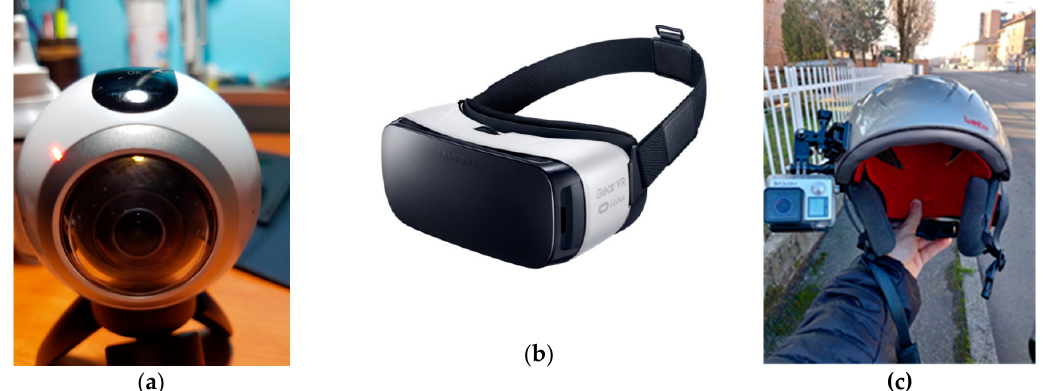
Figure 1. Samsung gear 360 camera ( a ); Samsung Gear VR produced by Oculus ( b ) and GoPro Hero 4 attached to a helmet ( c ).